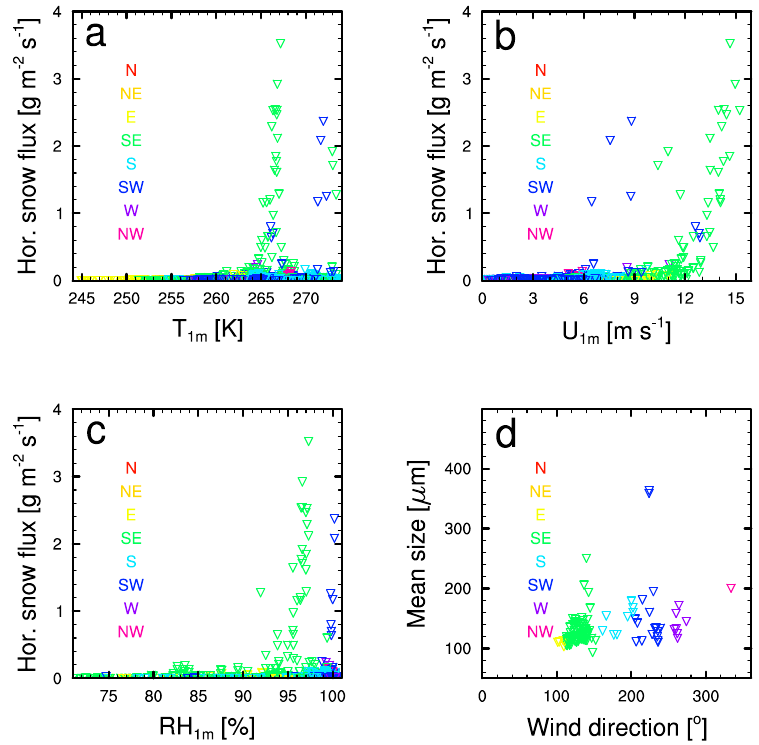
Fig. 5. Horizontal snow flux [gm − 2 s − 1 ] vs. (a) temperature (b) wind speed and (c) relative humidity, all measured at ∼ 1m above the snow surface. (d) Mean snow particle size as a function of wind